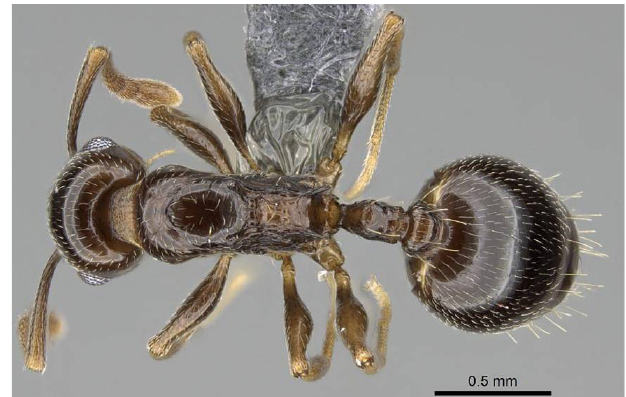
Fig 9 . Temnothorax ansei sp.n. intermorphic individual in dorsal view. Photo credit: Michele Esposito, from www.AntWeb.org,CASENT 0919826_D, published with permission.